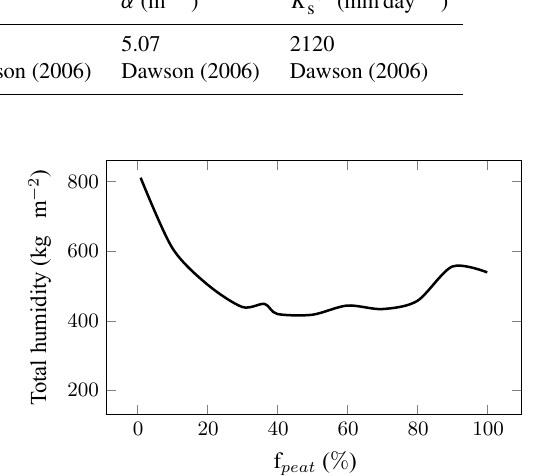
Table 1. Van Genuchten parameters applied to organic peat soils for the column of peat soil in this study and their corresponding references. Soil θ s